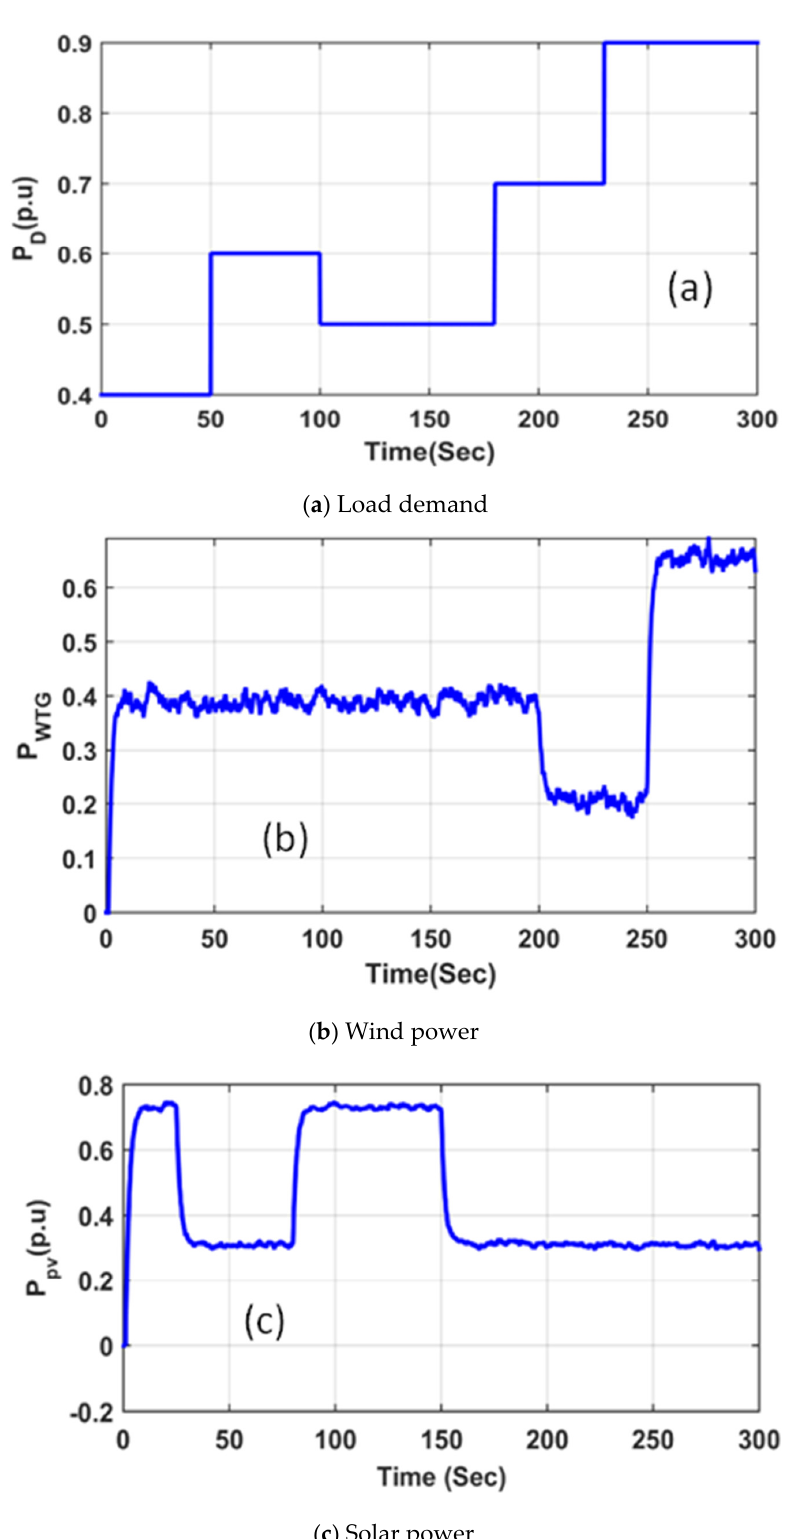
Figure 8. ( a ) P D ( b ) P WTG ( c ) P PV (independent